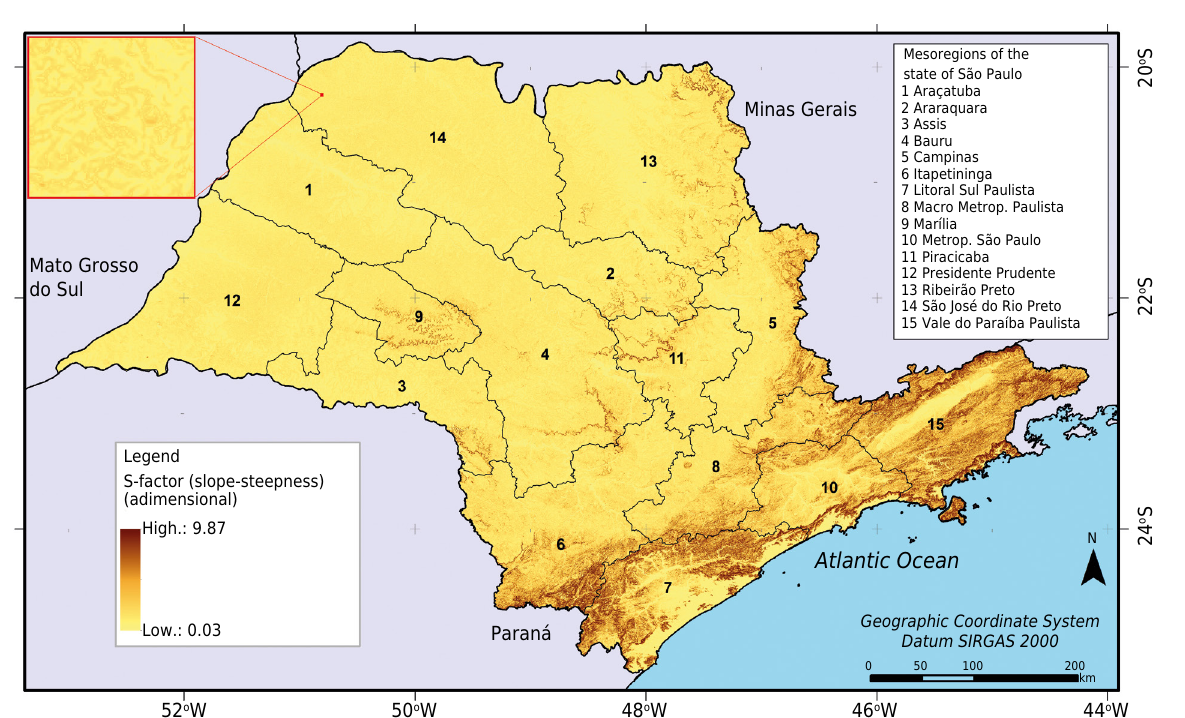
Figure 6. S-factor map of the state of São